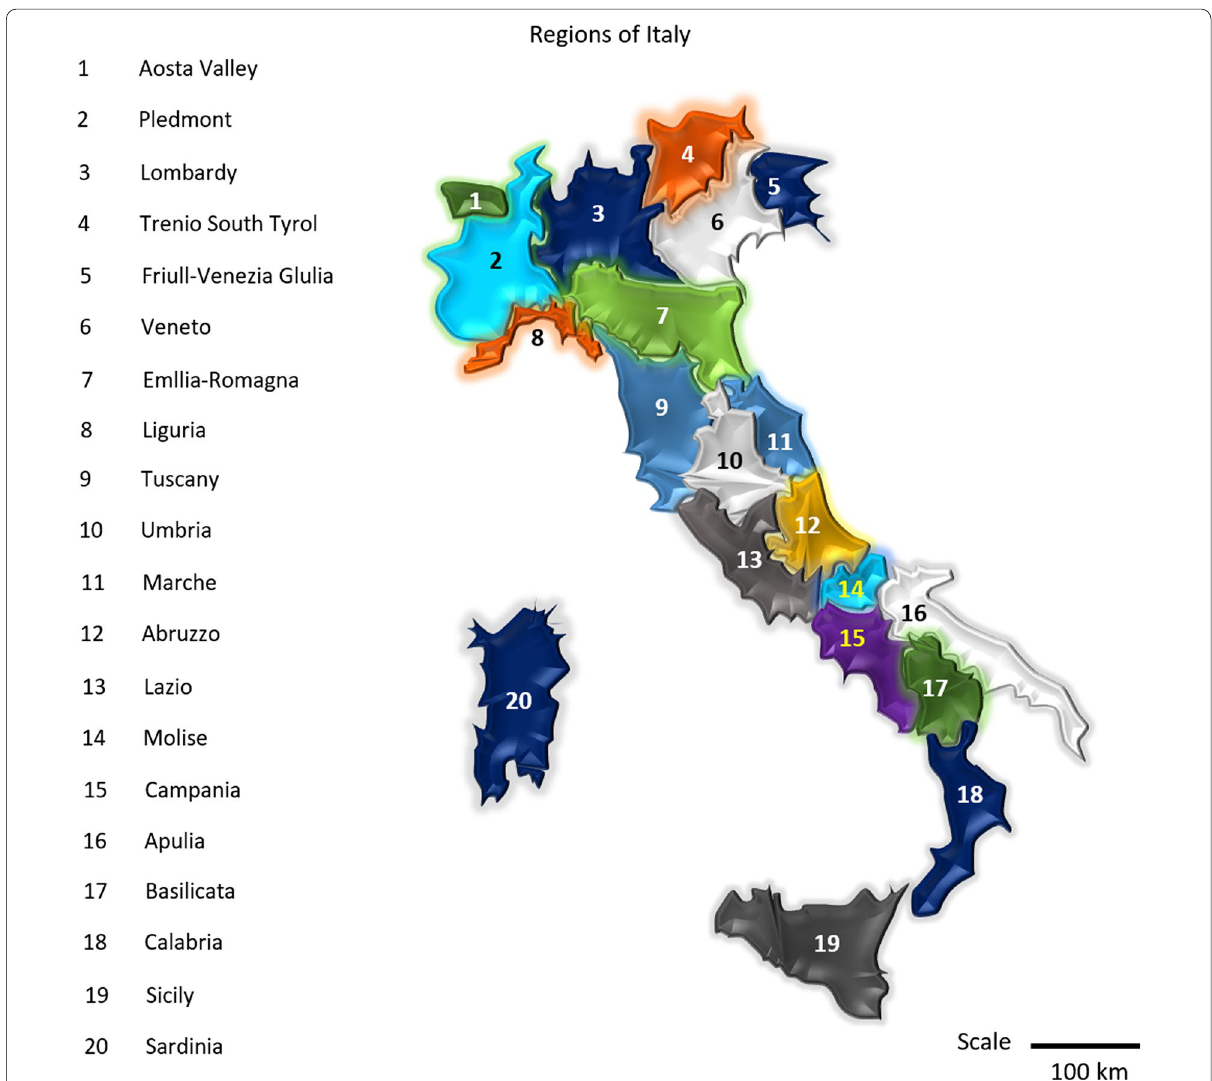
Fig. 1 A physical map of Italy showing all the regions of the